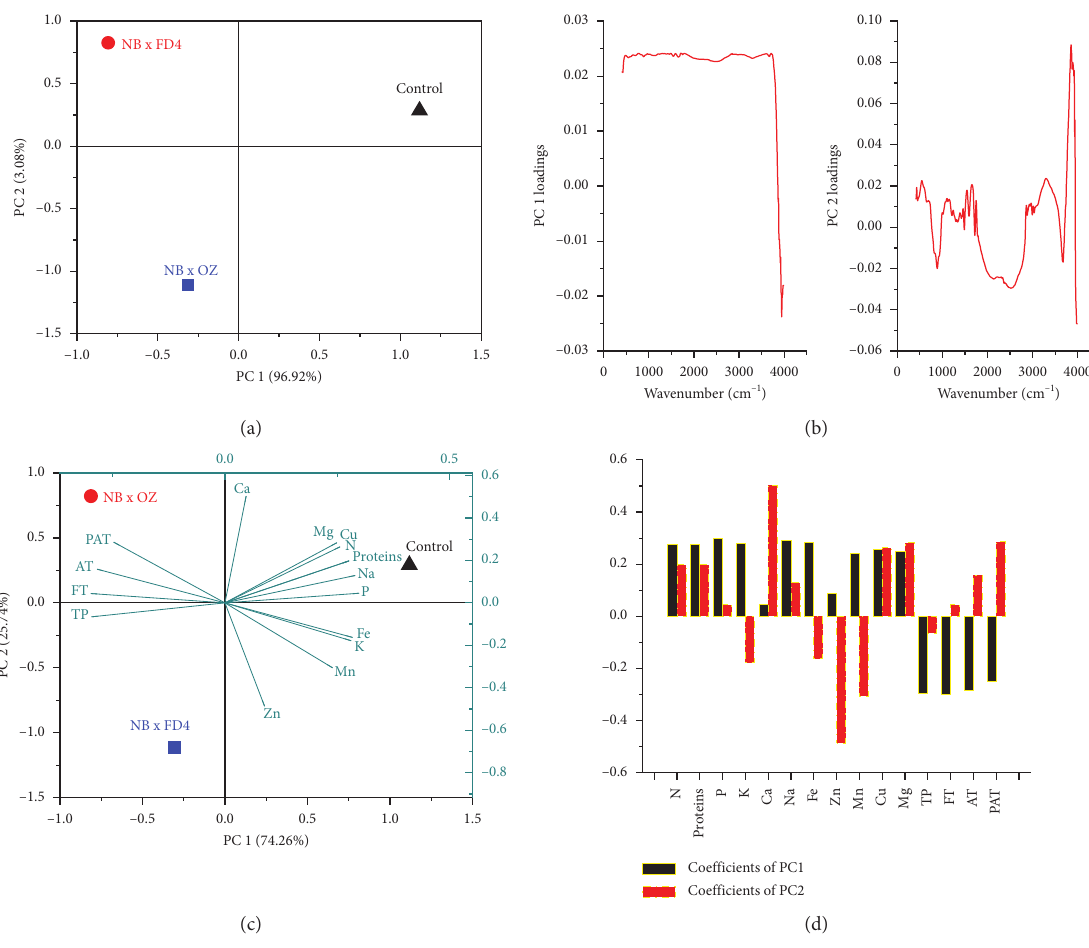
Figure 6: PCA 2D plot showing the effect of separate and simultaneous effect on fig seeds vibrational fingerprints (a) and biochemical attributes alongside minerals (b) with components most contributing to both PCA patterns (b and d). FD4: Frond d’Oued N ° 4; OZ :